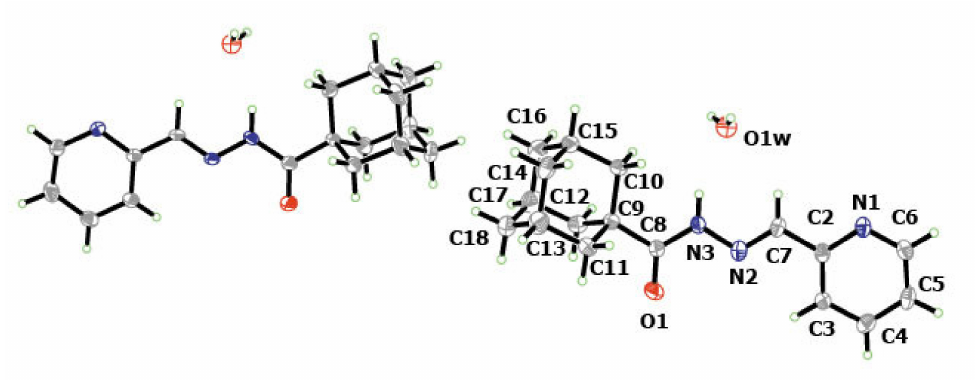
Figure 3. Molecular units of APH show two di ff erent crystallographic molecules in the unit cell. Ellipsoids are drawn at the 30% probability level. The numbered molecule is symmetrically equivalent to the other. Table 2. Crystallographic and refinement data for APH and 1 . Table 2. Crystallographic and refinement data for APH and 1 .